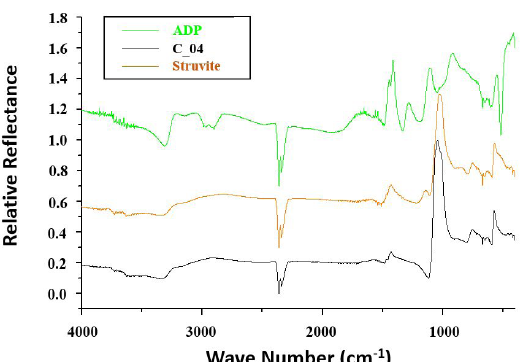
Figure 15. FTIR spectra of ammonium dihydrogen phosphate (NH H PO , ADP) compositions C_S and C_04 prepared from 4 2 4 MgO powders calcined at 1100 ° C / 2